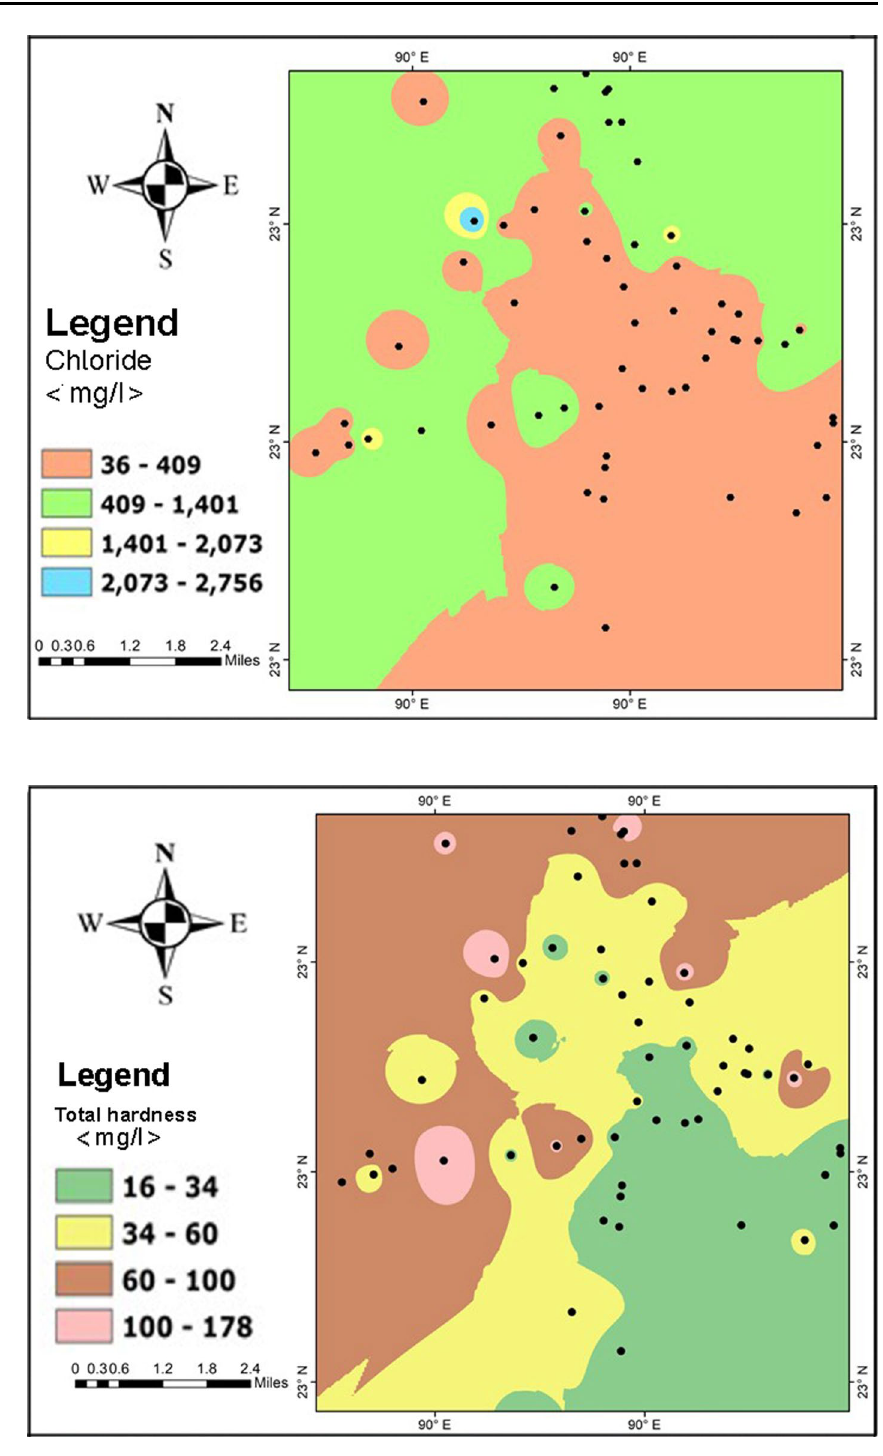
Fig. 7 Spatial distribution of chloride in selected tube wells water